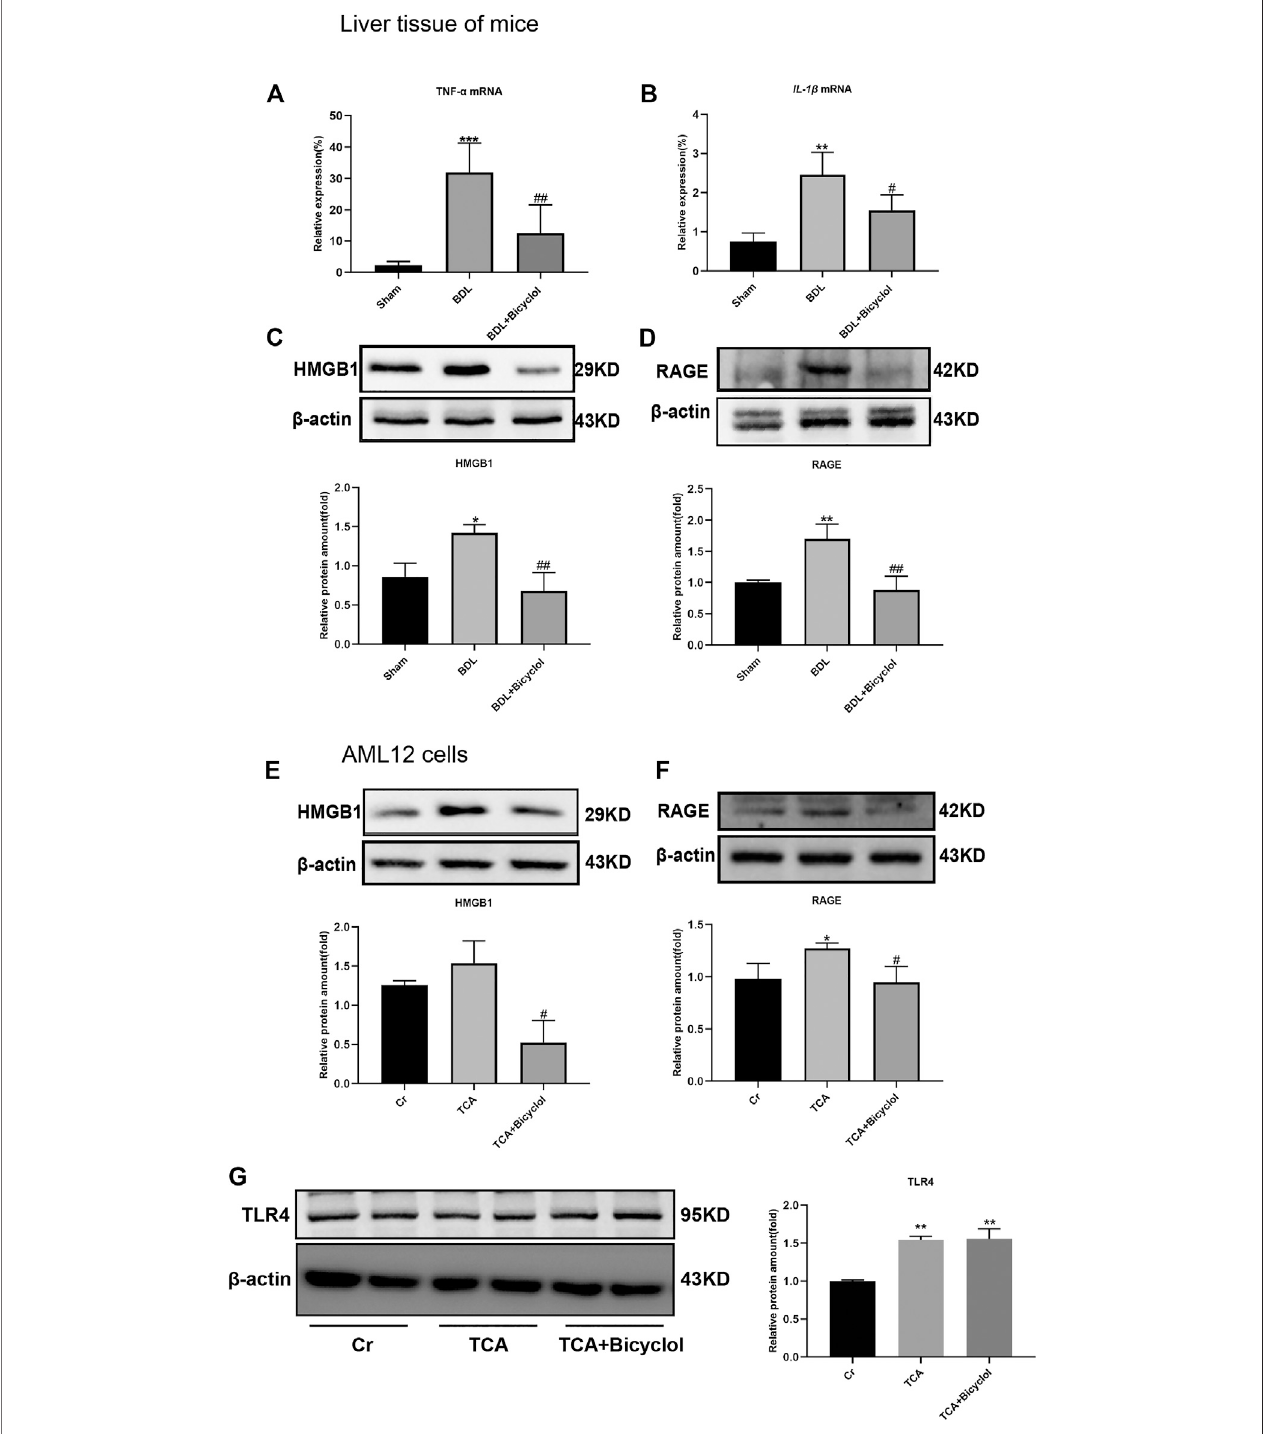
FIGURE4| Effectofbicyclolonin fl ammatorycytokines,HMGB1,anditsreceptorRAGEandTLR4.ThemRNAlevelofTnf- α (A) andIL-1 β (B) inmouselivertissue. (C,D) ImmunoblotsforHMGB1andRAGEinmouseliver. (E,F) ImmunoblotsforHMGB1andRAGEinAML12cells. (G) ImmunoblotsforTLR4inAML12cells.* p < 0.05, ** p < 0.01, *** p < 0.001 vs. sham or Cr; # p < 0.05, ## p < 0.01 vs. BDL or TCA. Protein levels were normalized to levels of β -actin.